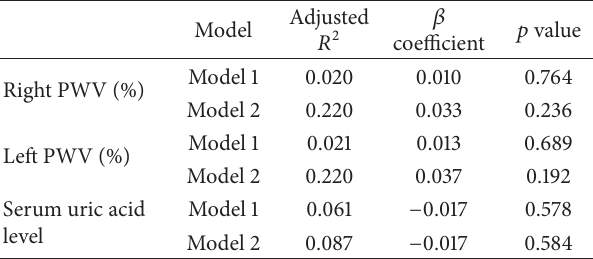
Table 5: The relationship between FEV1 (% pred) and PWV (%) or serum uric acid